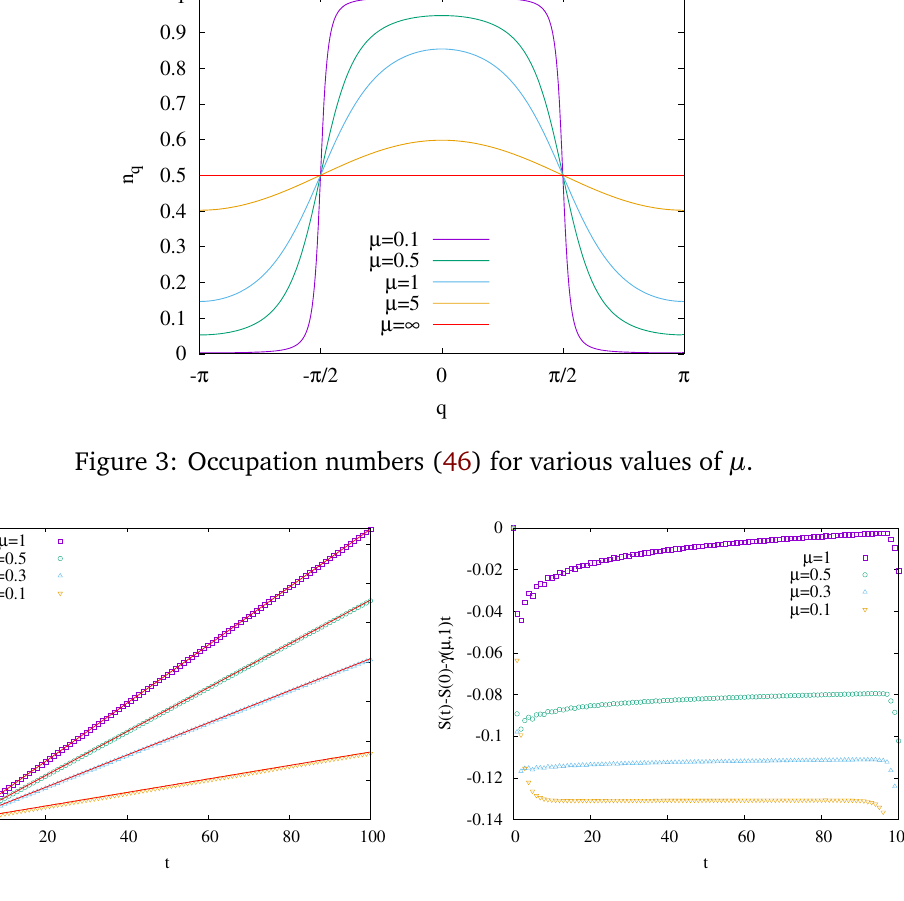
Figure 4: Left: entropy evolution for a homogeneous chain ( λ = 1) with L = 100 after a global quench for various values of µ . The red lines show the slopes calculated from (45) with the occupation (46). Right: deviation from the quasiparticle